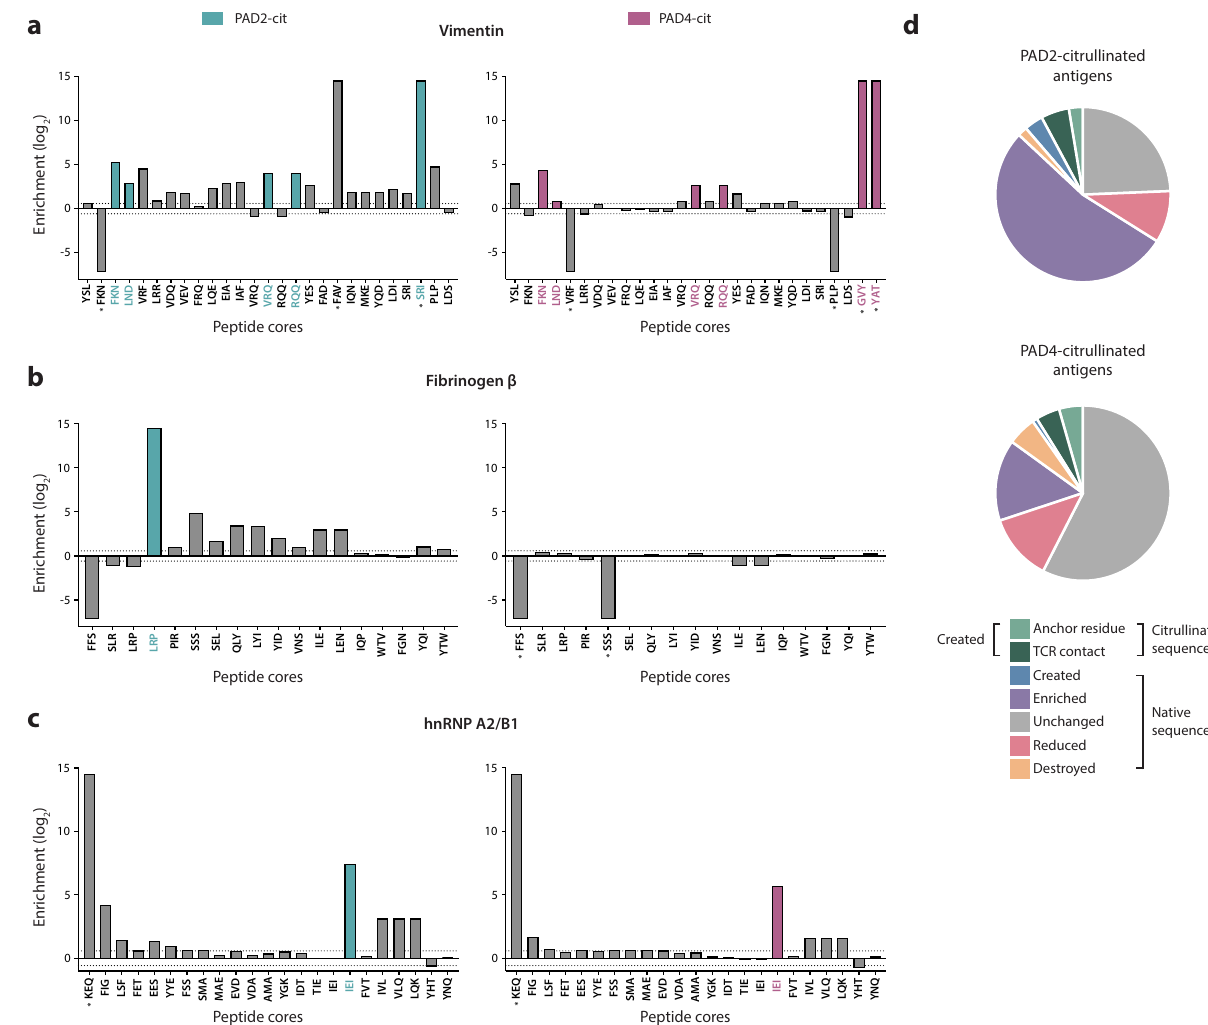
Fig.4|PutativeRA-associatedHLA-DRpeptide-bindingcoresprimarilyconsist of native sequences enriched by citrullination. a – c Log 2 enrichment of putative bindingcores(<500nM)predicted bytheNetMHCII-2.3algorithm,denotedbythe fi rst three amino acids of the peptidecore. Cores with positive values are enriched in the PAD2- or PAD4-citrullinated (cit) samples, while those with negative values